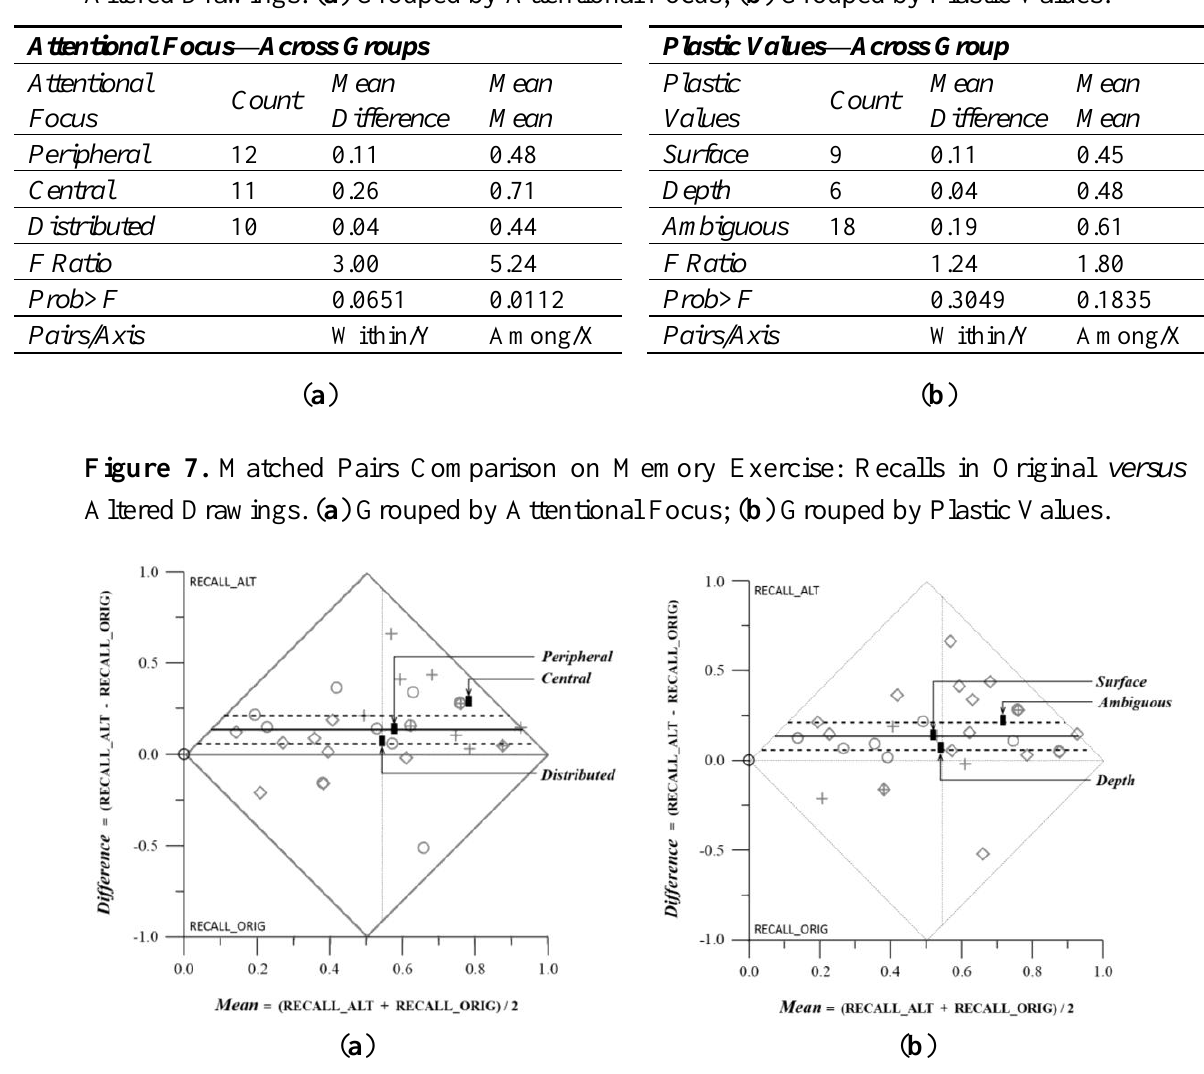
Table 5. Matched Pairs Comparison on Memory Exercise: Recalls in Original versus Altered Drawings. ( a ) Grouped by Attentional Focus; ( b ) Grouped by Plastic Values.